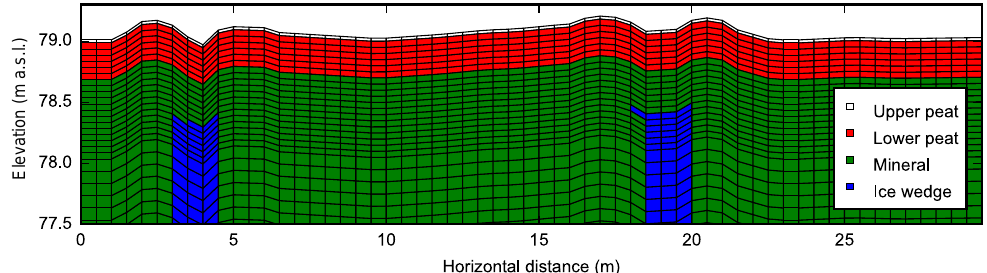
Figure 3. Schematic of the near-surface portion of the 2-D mesh of the field site (vertical exaggeration = 4). Mesh extends to 50m below the ground surface. Table 1. Ground physical (hydraulic and thermal) properties used in model. Residual Van Van Saturated Saturated Ground